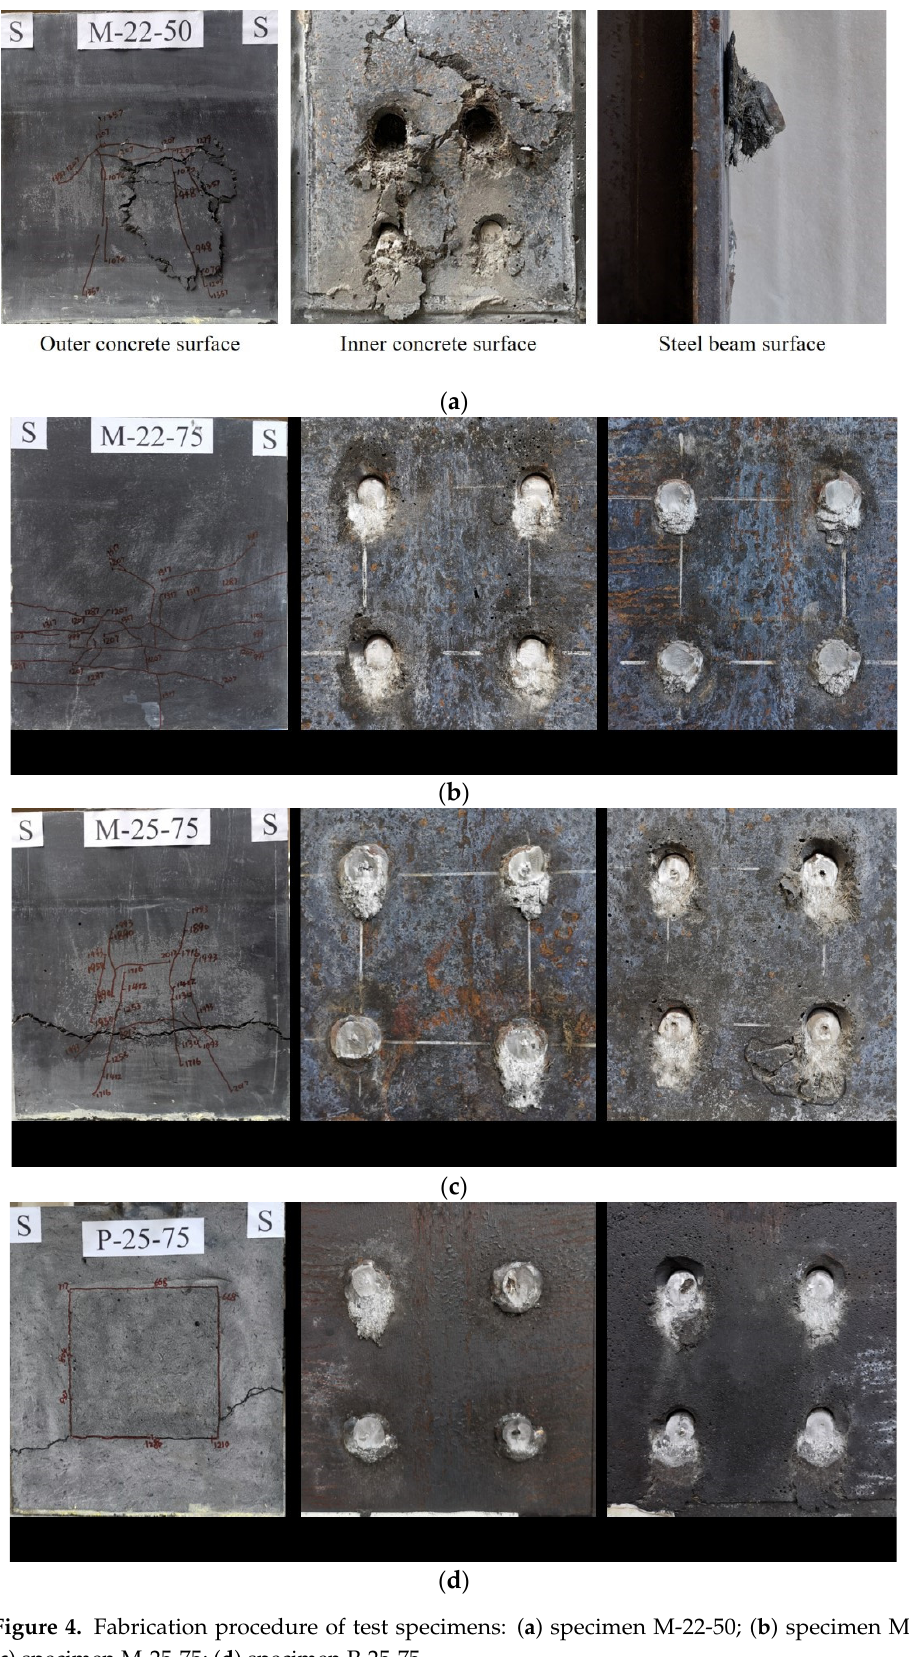
Figure 4. Fabrication procedure of test specimens: ( a ) specimen M-22-50; ( b ) specimen M-22-75; ( c ) specimen M-25-75; ( d ) specimen P-25-75.